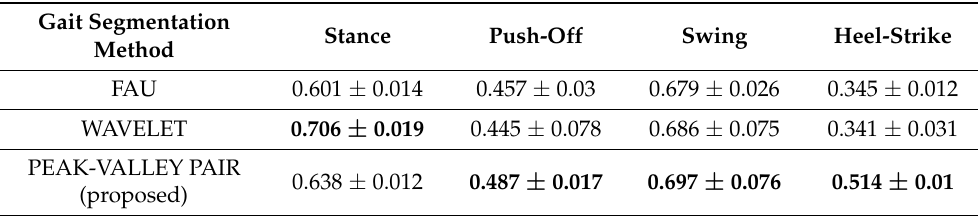
Table 5. Gait segmentation results for different methods in IoU values. Best results for each speed group are highlighted in bold